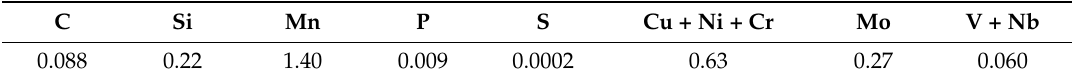
Table 1. Chemical composition of SA738Gr.B steel plates (wt %, Fe: